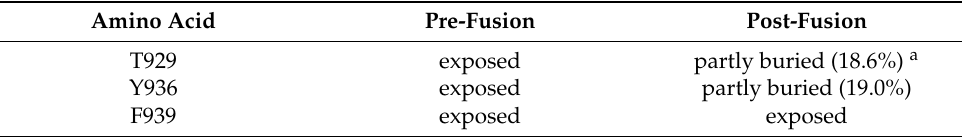
Table 2. Solvent accessibility of mutated residues in the pre-fusion and post-fusion conformations.